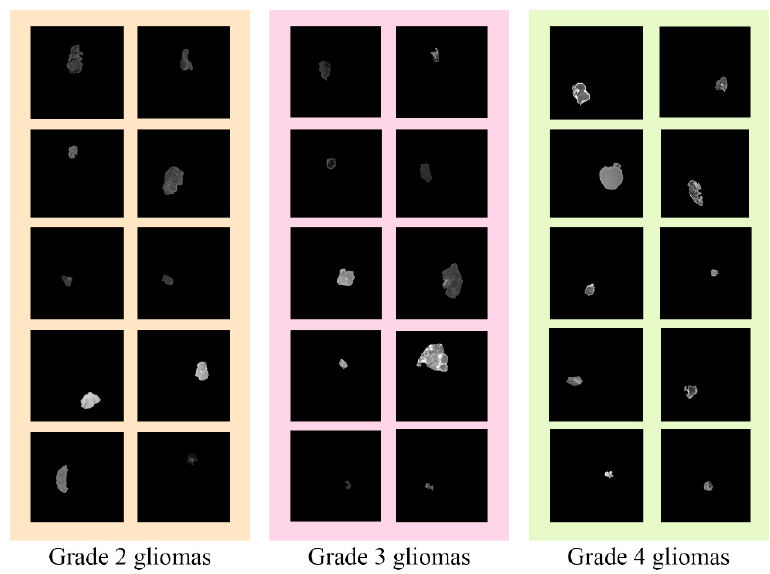
Figure 2. Extracted tumor areas as input images to the deep convolutional neural network. (http://cancerimagingarchive.net/—“License” and the CC BY license (https://creativecommons.org/licenses/by/3.0/).